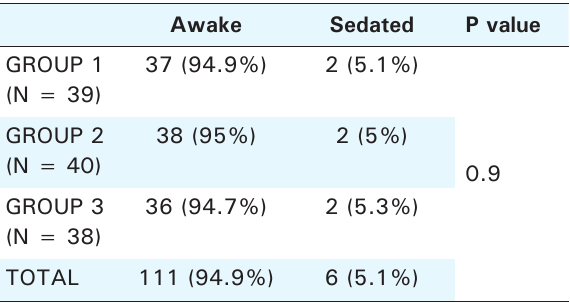
Figure 2b. satisfaction VAs vs table 2. comparison of Incidence of sedation Values are expressed in number of patients (%)